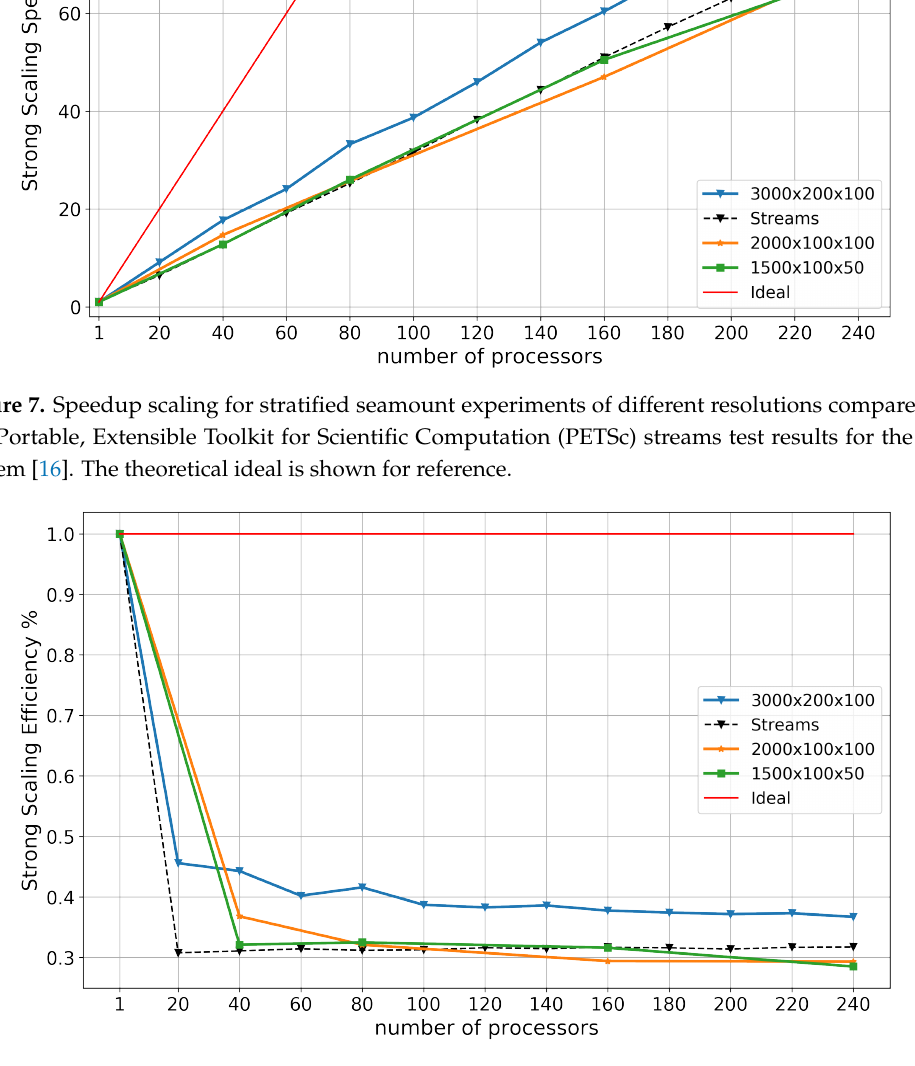
Figure 8. Efficiency for stratified seamount experiments of different resolutions compared to the PETSc streams test results for the test system [16]. A theoretical ideal is shown for